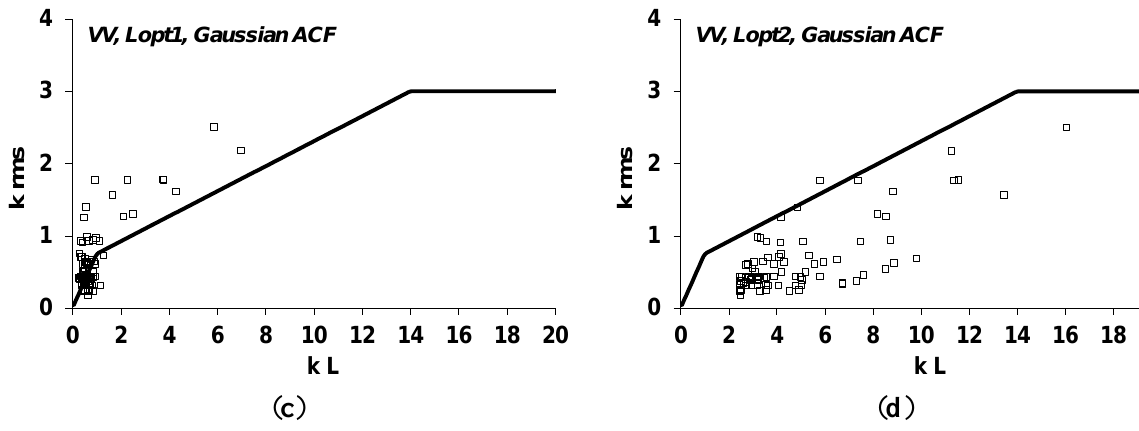
Figure 4. Validity regions of the IEM model in k.rms - L space (where k is the wave number) for Gaussian ACF, and the location of experimental data points [1]. All experimental data points are within the IEM limits with Lopt2 . ( a ): HH polarization and L = Lopt1 , ( b ): HH polarization and L = Lopt2 , ( c ): VV polarization and L = Lopt1 , ( d ): VV polarization and L = Lopt2